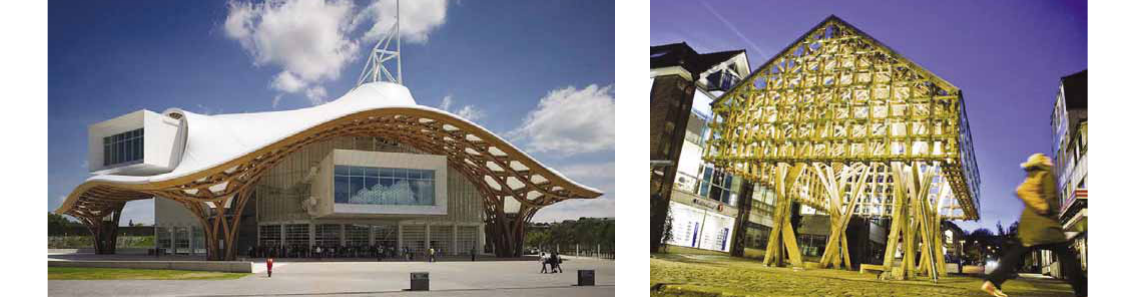
36 pav. „Pompidu-Metz“ centras, Prancūzija, archit. S. Banas, 2010 m. Fig. 36. “Pompidu-Metz” center, France, archit. S. Ban, 2010